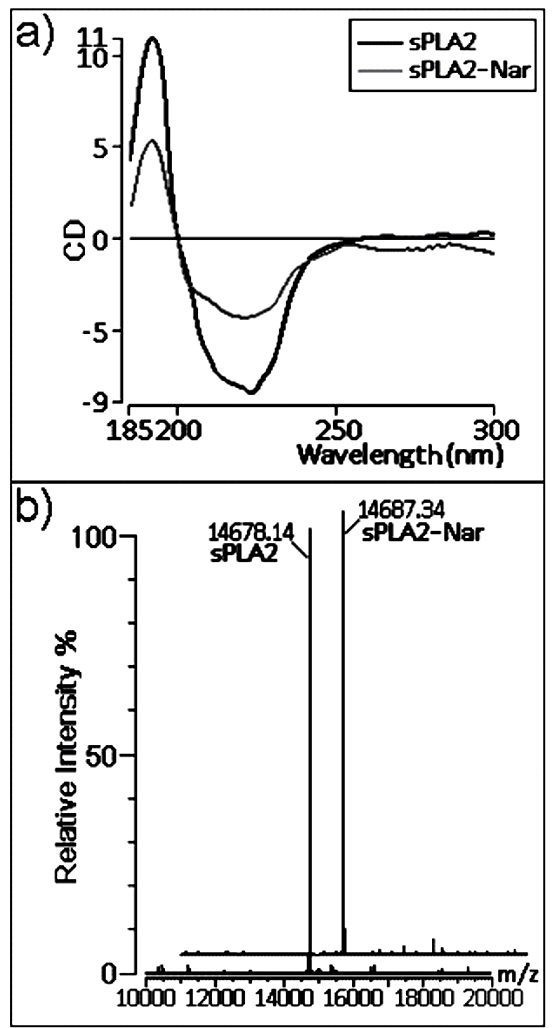
Figure 5. (a) CD spectra of native sPLA2 and sPLA2-Nar. Data over the range of 185–300 nm are shown. The CD spectra are expressed in ellipticity units in millidegrees. (b) The mass measurement of native and naringin-treated sPLA2 by MALDI-TOFF mass spectrometry resulting in a molecular mass of 14,678.14 Da for native sPLA2 and 14,687.34 Da for